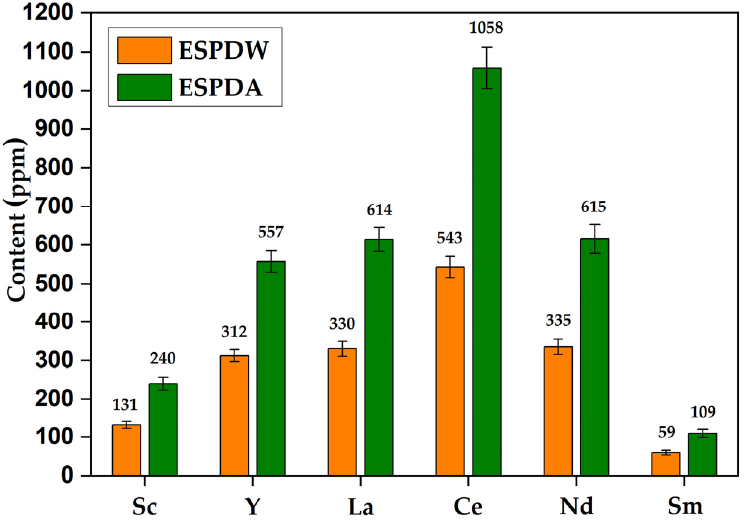
Figure 9. Content of rare earth elements in water-leached electrostatic precipitator dust and alkali-leached electrostatic precipitator dust.